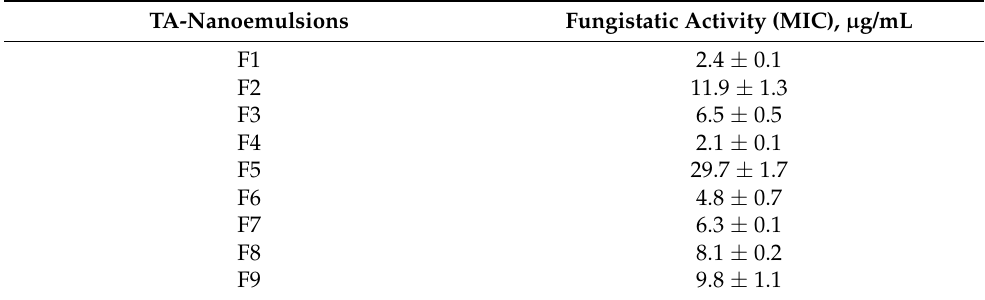
Table 5. Minimum inhibitory concentration (MIC) of triamcinolone acetonide-loaded nanoemulsions determined against Candida albicans